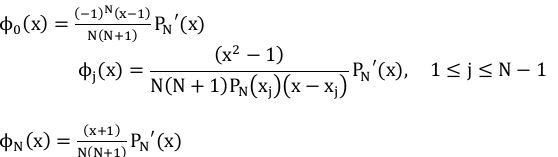
Figure 1: The basis functions ϕ j are defined as